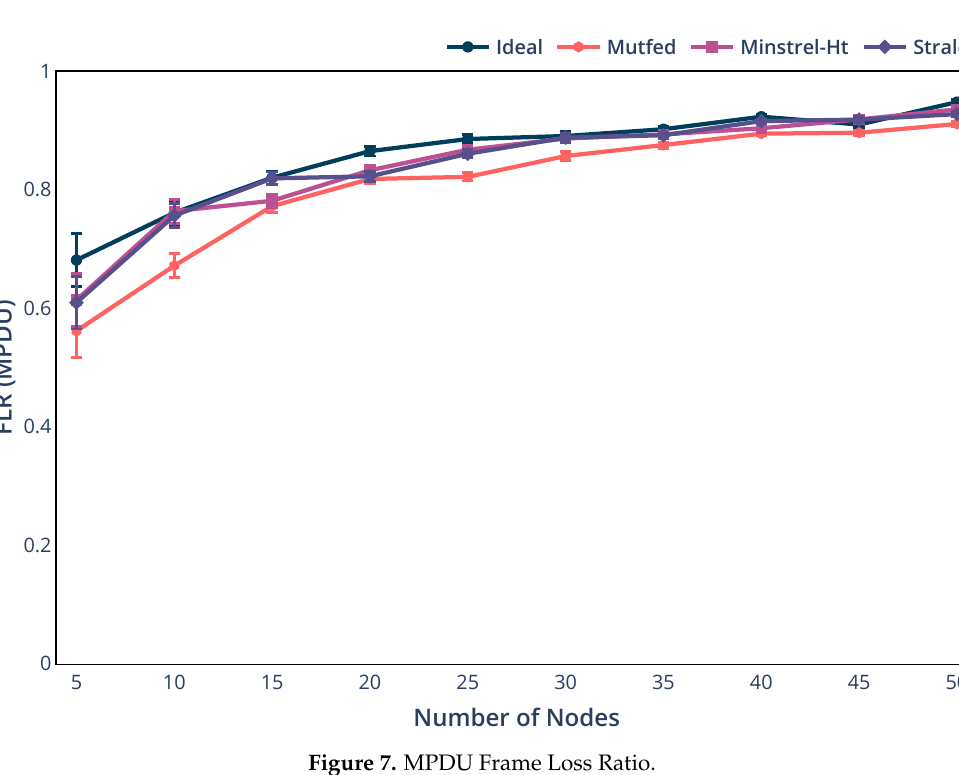
Figure 7. MPDU Frame Loss